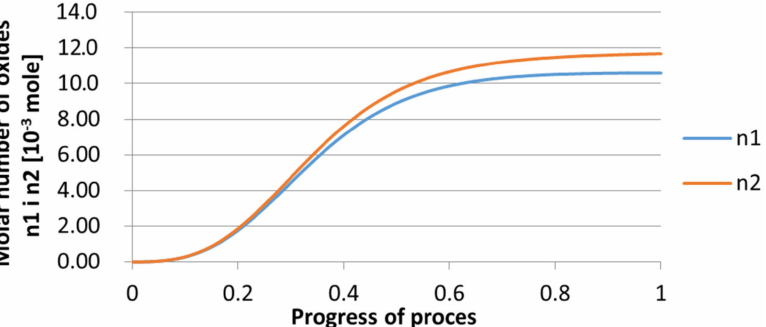
Figure 15. Increase of bi-component nuclei of oxides n 1 (Al 2 O 3 ) and n 2 (Y 2 O 3 ) in steel 1 (for r 0 = 1 µ m).